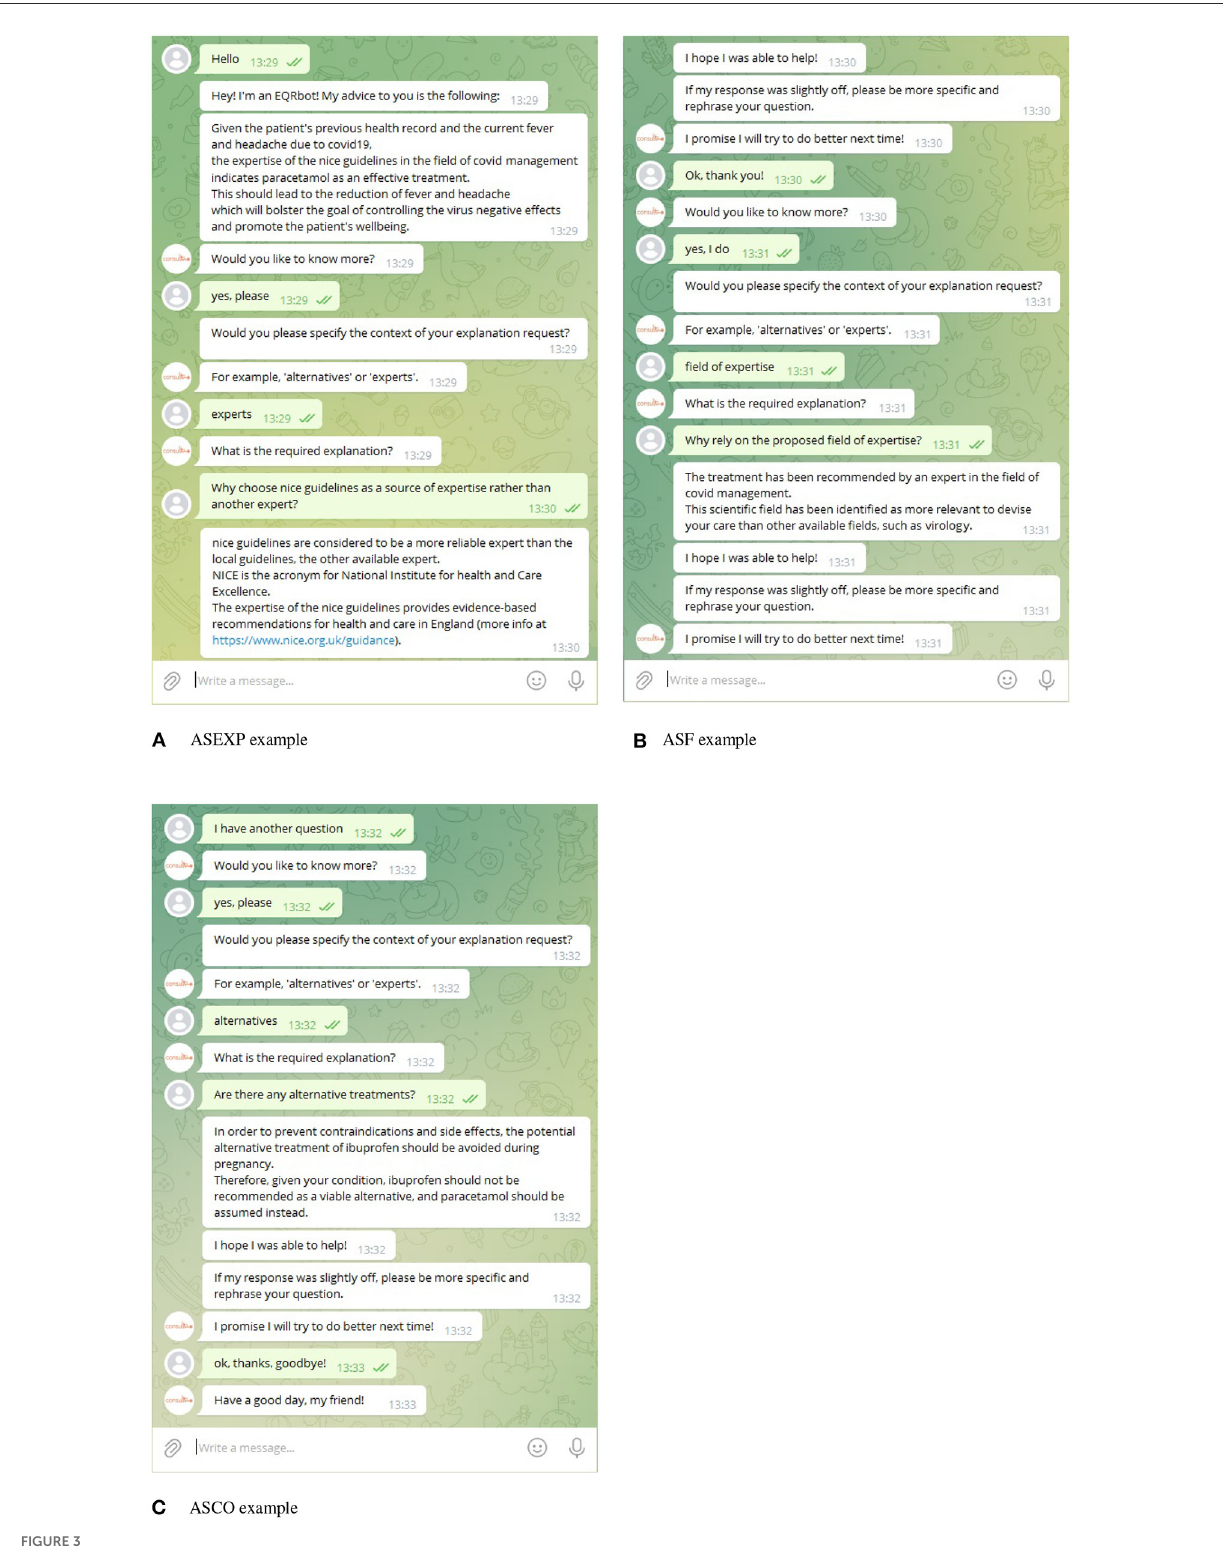
FIGURE3 Instance of a conversation with the EQRbot starting from the explanation of Example 1. The displayed interaction captures the patient inquiries regarding the involved expert (A) , the field of expertise (B) and possible alternatives to the proposed treatment (C) . Matching the user’s input, context and the information stored in the system, the EQRbot provides the additional requested explanation via the acceptable instantiations of the, respectively, ASEXP, ASF, and ASCO